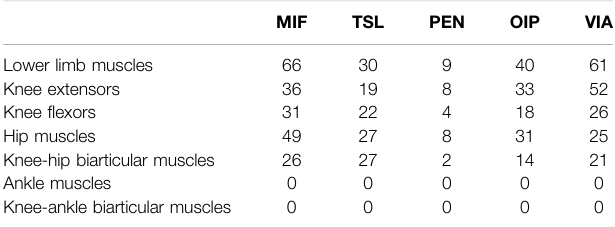
TABLE 2 | Contribution factor (in percent) of the input parameters of the studied muscle groups toward the overall variability in the knee contact force estimates at deepest knee fl exion angle during